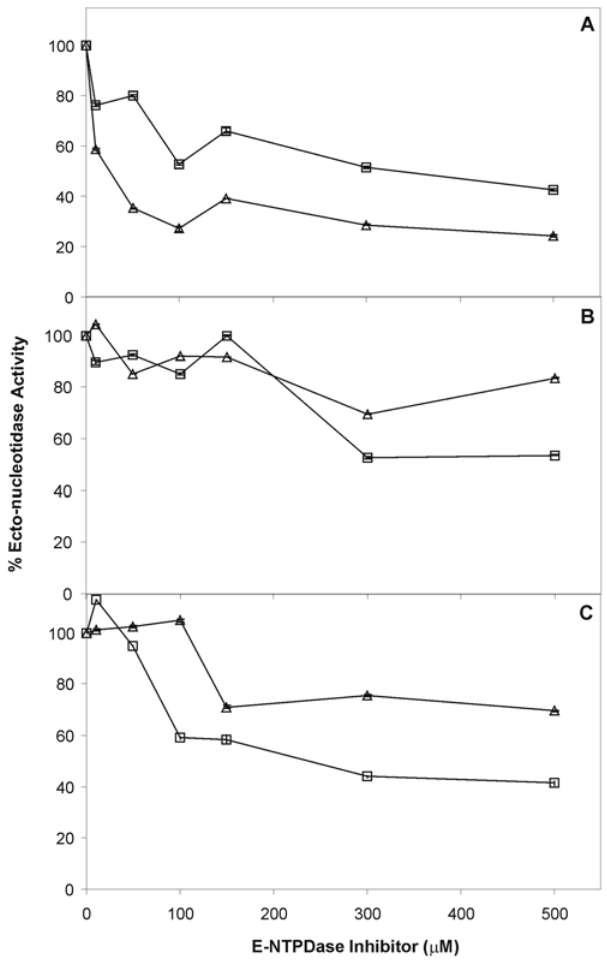
Figure 3. Effect of inhibitors in the ecto-ATPDase activity of Y strain P1 trypomastigotes. Parasites were pre-incubated for 10 min with different concentrations of Suramin (Panel A), ARL 67156 (Panel B) or Gadolinium (Panel C) and ecto-ATPDase activities were measured. Ecto-ATPase ( D ) and ecto-ADPase ( % ) activities are expressed as percentage of control activity (without inhibitors). Data are mean 6 standard error of two independent experiments in triplicate.